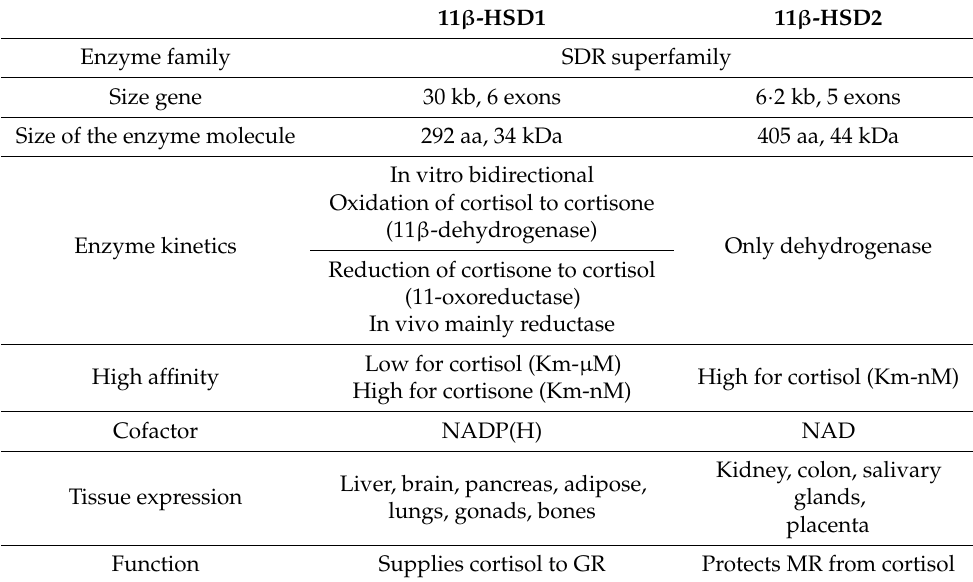
Table 1. Direct comparison between the characteristics of 11 β -HSD1 and 11 β -HSD2